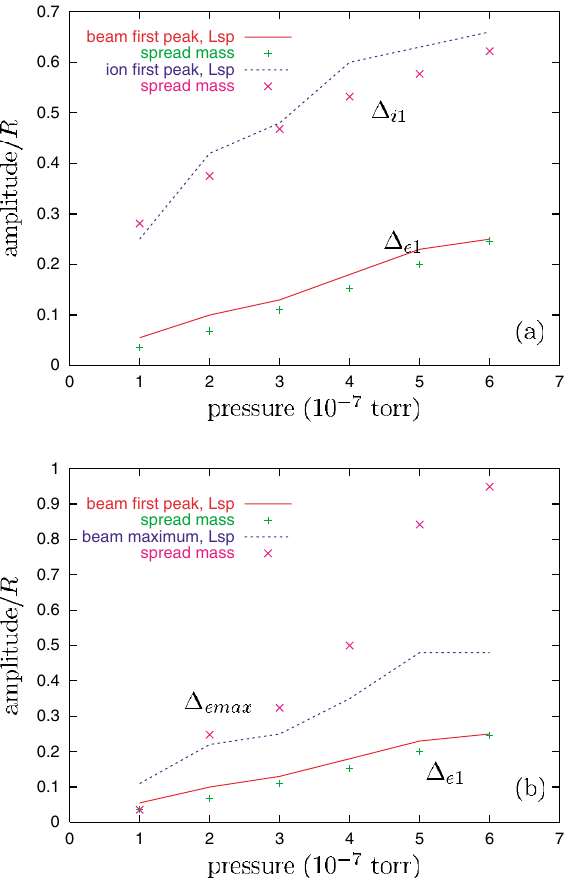
FIG. 5. (Color) Comparison of beam and channel centroids at the end of a 50-m drift, as calculated by the spread-mass and LSP calculations, at pressures of (a) 10 (cid:1) 7 torr , (b) 3 (cid:3) 10 (cid:1) 7 torr , and (c) 6 (cid:3) 10 (cid:1) 7 torr . The locations of the peaks " are shown in (c) for the LSP " e max